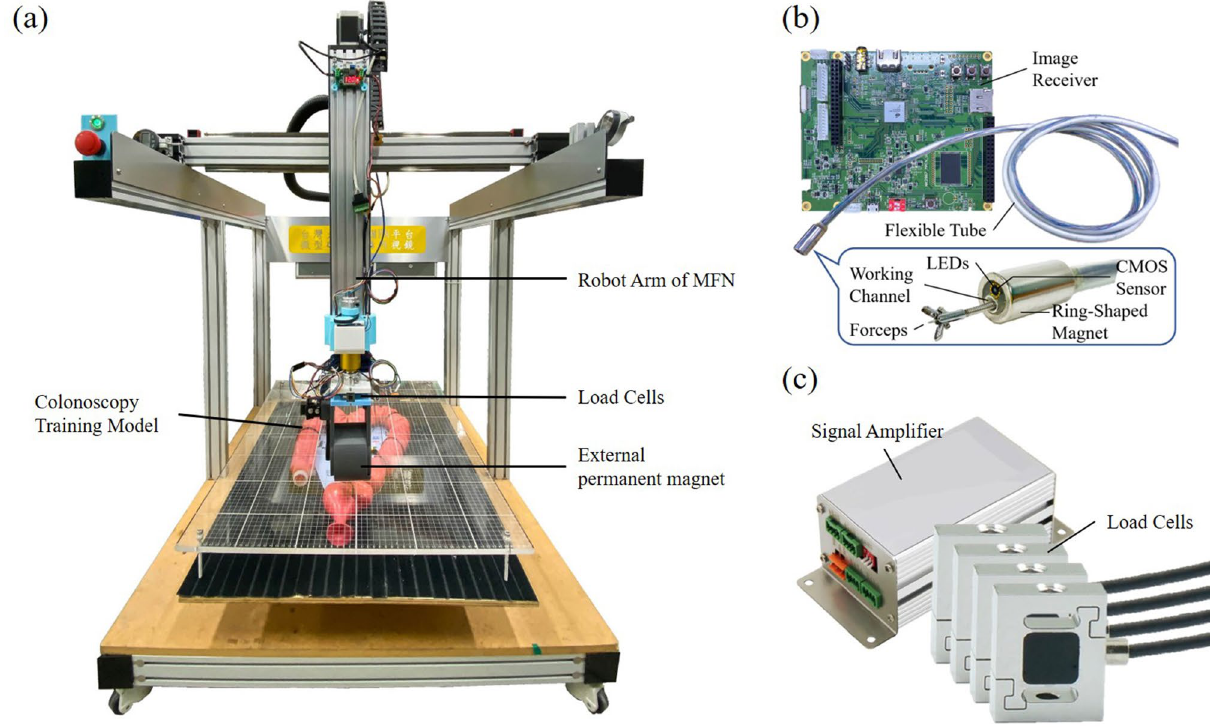
Figure 1. The architecture of magnetic-assisted colonoscopy (MAC) system. ( a ) Magnetic field navigator (MFN). ( b ) Disposable magnetic colonoscope (MC) and its receiver. ( c ) Tension/compression load cells and their signal